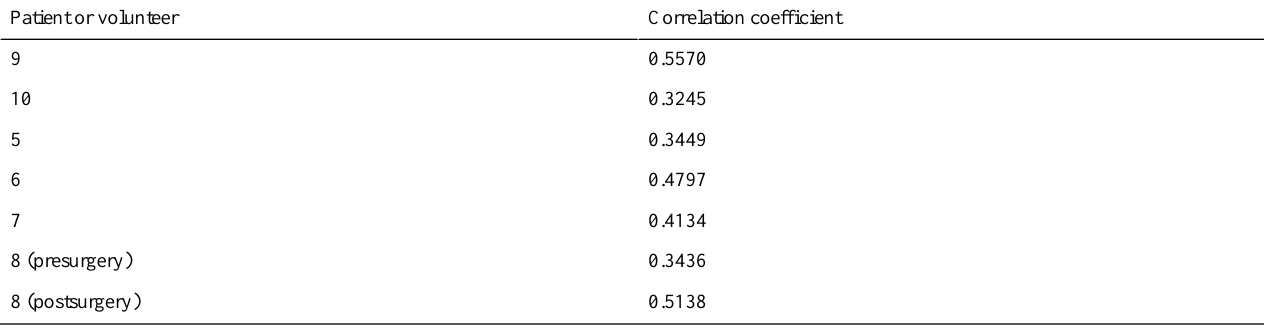
Table 4. Pearson correlation coefficients between phonograms obtained using the Auscul Pi and 3M Littmann stethoscopes (all P values <.001).